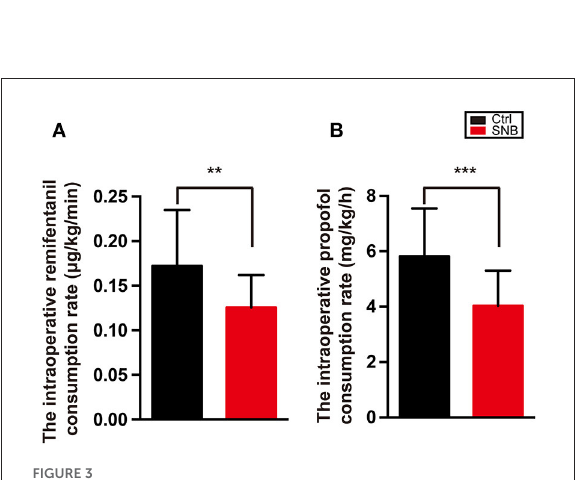
FIGURE3 The intraoperative total remifentanil (A) and propofol (B) consumption rate in group Ctrl and group SNB. Data are presented as mean ± SD. ** P < 0.01; *** P < 0.001. group Ctrl, control group; group SNB, scalp nerve block group.